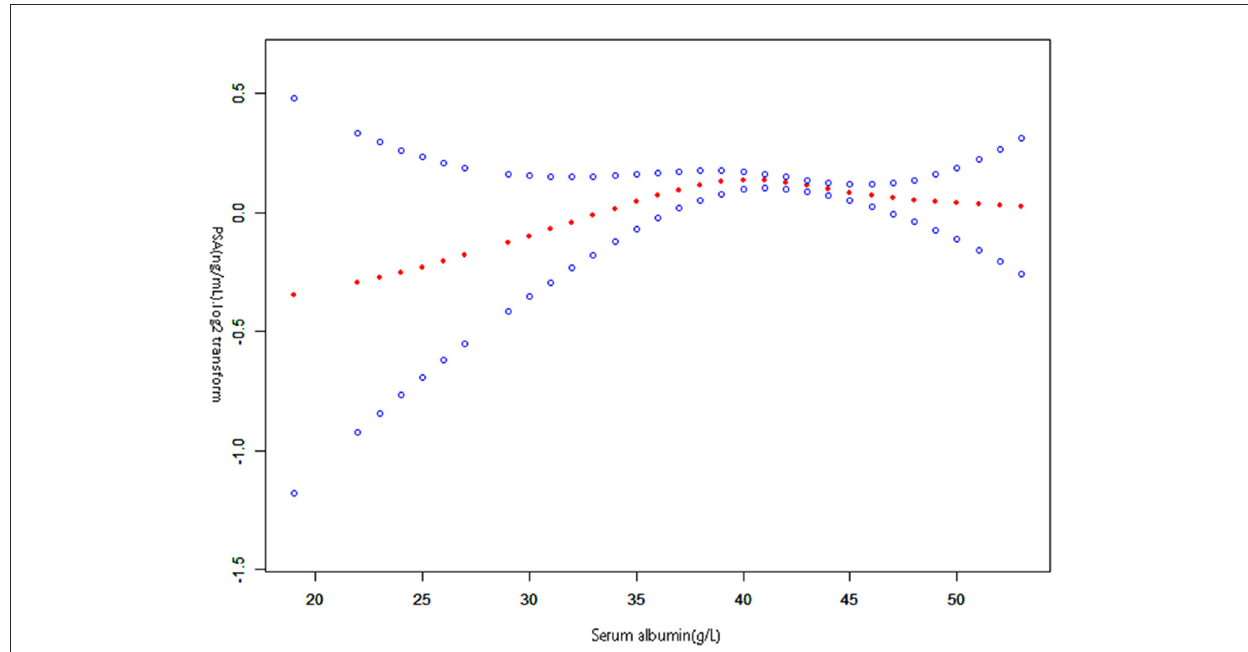
FIGURE2 The relationship between serum albumin and prostate-specific antigen. A non-linear relationship between them was detected after adjusting for Race, Education level, Diabetes history, Failing kidney history, Emphysema history, Stroke history, Marital status history, Hypertension history, Asthma history, Coronary heart disease history; Age (year), Poverty income ratio (PIR), Serum glucose (mmol/L), Body mass index (kg/m 2 ), Creatinine (umol/L), Aspartate aminotransferase (U/L), Alanine aminotransferase (U/L), Cholesterol (mmol/L), Blood urea nitrogen (mmol/L), Lactic dehydrogenase (U/L), Serum uric acid (umol/L), Triglycerides (mmol/L).